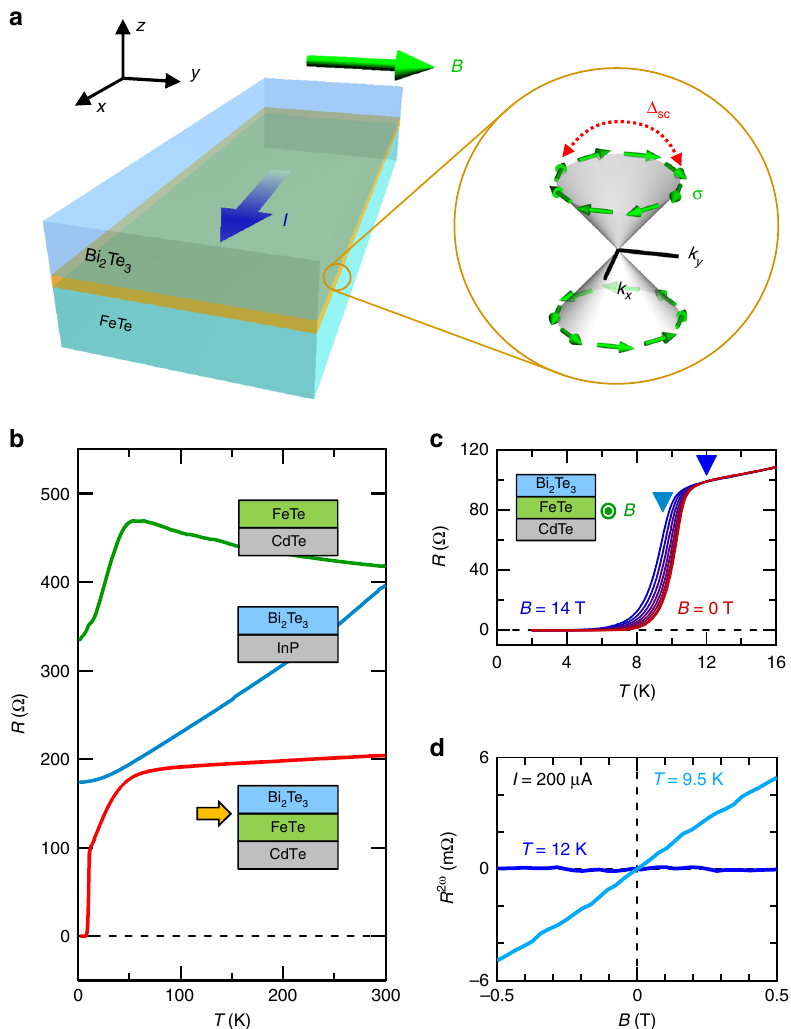
Fig. 1 Nonreciprocal transport in a Bi 2 Te 3 /FeTe heterostructure. a The illustration of a Bi 2 Te 3 /FeTe heterostructure (Bi 2 Te 3 : blue, FeTe: green). The interface of Bi 2 Te 3 and FeTe shows superconductivity (yellow region). The nonreciprocal transport is measured with current I along x -direction under the in-plane magnetic fi eld B (along y -direction) perpendicular to the current. The mutual interaction between spin – momentum-locked topological surface state and superconductivity (as represented by Δ SC ) is expected at the interface as expressed in momentum space in the right circle. σ represents the spin direction of the electron. b Temperature dependence of resistance in FeTe(18 nm)/CdTe(100) (green), Bi 2 Te 3 (15 nm)/InP(111) (blue) and Bi 2 Te 3 (15 nm)/ FeTe(18 nm)/CdTe(100) (red) thin fi lms. The superconductivity and topological surface state appear at the interface between Bi 2 Te 3 and FeTe as denoted by the yellow allow. c The temperature dependence of resistance in Bi 2 Te 3 /FeTe heterostructure under in-plane magnetic fi eld B = 0, 2, 4, 6, 8, 10, 12, and 14 T. The resistance is measured under I = 1 μ A. d The magnetic fi eld dependence of R 2 ω in Bi 2 Te 3 /FeTe heterostructure at T = 12 K (blue, normal state) and at T = 9.5 K (light blue, below the superconducting onset temperature) measured with a current magnitude of I = 200 μ